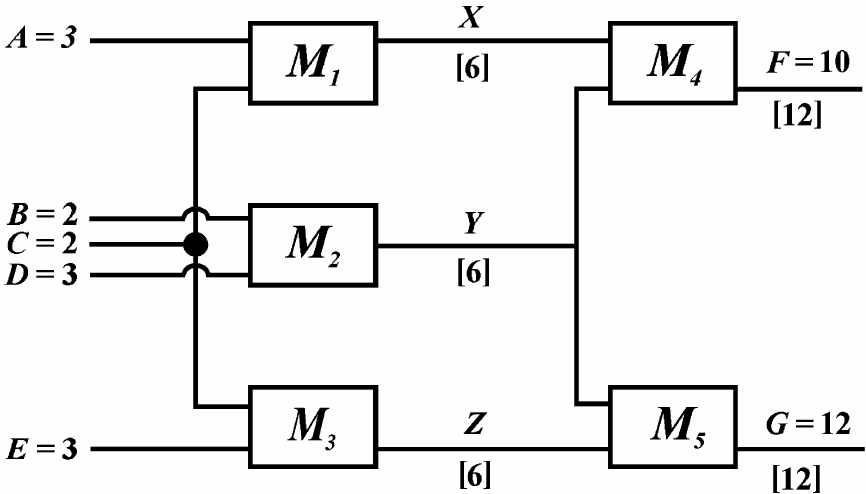
Figure 25. An electronic circuit containing three multipliers, M adders, M and M . Correct outputs are shown in square brackets. Redrawn from Figure 5.6 4 5 in [59](p. 263), with permission from the copyright holder,